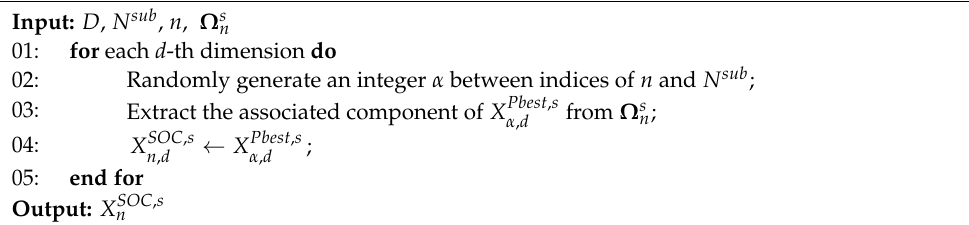
Algorithm 3. Pseudocode used to generate the social exemplar for each non-fittest